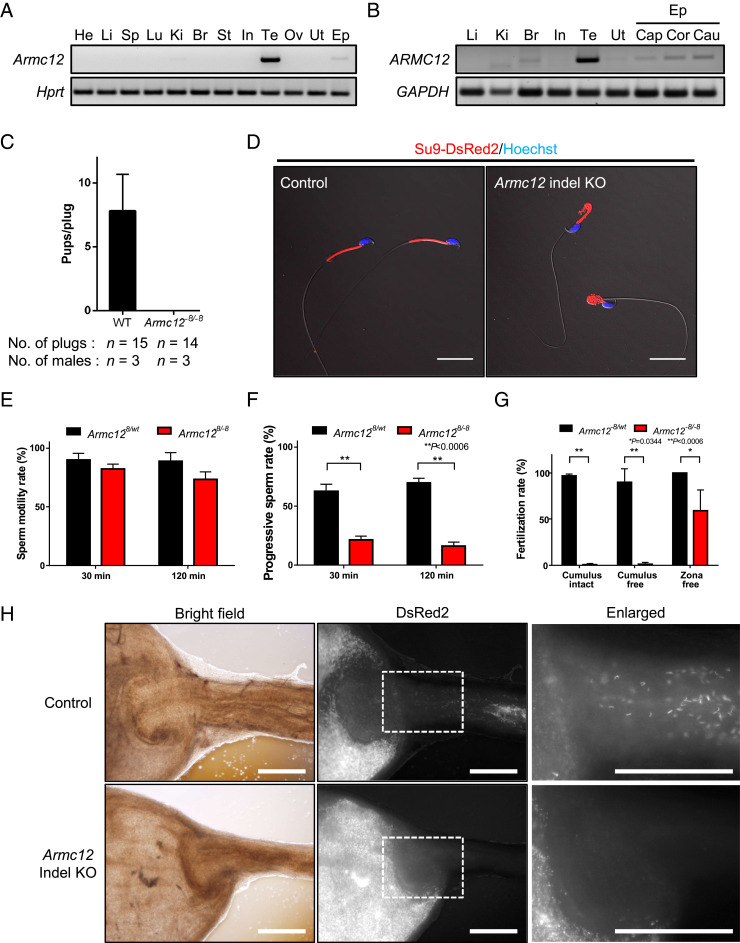
Armc12 indel KO male mice are sterile due to reduced sperm motility and abnormal sperm morphology. (A and B) RT-PCR for Armc12 from various mouse tissues (A) and RT-PCR for ARMC12 from various human tissues (B) (He, heart; Li, liver; Sp, spleen; Lu, lung; Ki, kidney; Br, brain; St, stomach; In, intestine; Te, testis; Ov, ovary; Ut, uterus; Ep, epididymis; Cap, caput; Cor, corpus; Cau, Cauda). Hprt and GAPDH were used as controls. (C) Pregnancy rate of control and Armc12 indel KO male mice. (D) Sperm morphology of control and Armc12 indel KO mice with RBGS transgenes, which express mitochondria-targeted DsRed2 (red). Nuclei were stained with Hoechst 33342 (blue). (Scale bars, 20 µm.) (E) Sperm motility from control and Armc12 indel KO mice. Error bars represent SD (n = 3). (F) Progressive sperm rate of sperm from control and Armc12 indel KO mice. **P < 0.01, Student’s t test; error bars represent SD (n = 3). (G) Fertilization rate of IVF using control and Armc12 indel KO spermatozoa. Three types of oocytes (cumulus-intact, cumulus-free, and zona-free) were used for IVF. *P < 0.05, **P < 0.01, Student’s t test; error bars represent SD (n = 3). (H) Imaging of spermatozoa inside the female reproductive tract 2 to 3 h after observing vaginal plugs. (Left) Reproductive organs under normal bright-field conditions. (Middle) Red fluorescence of RBGS spermatozoa in the female reproductive tract. (Right) Magnified images of the boxed areas. Fluorescent images were false-colored using ImageJ software. (Scale bars, 500 µm.)